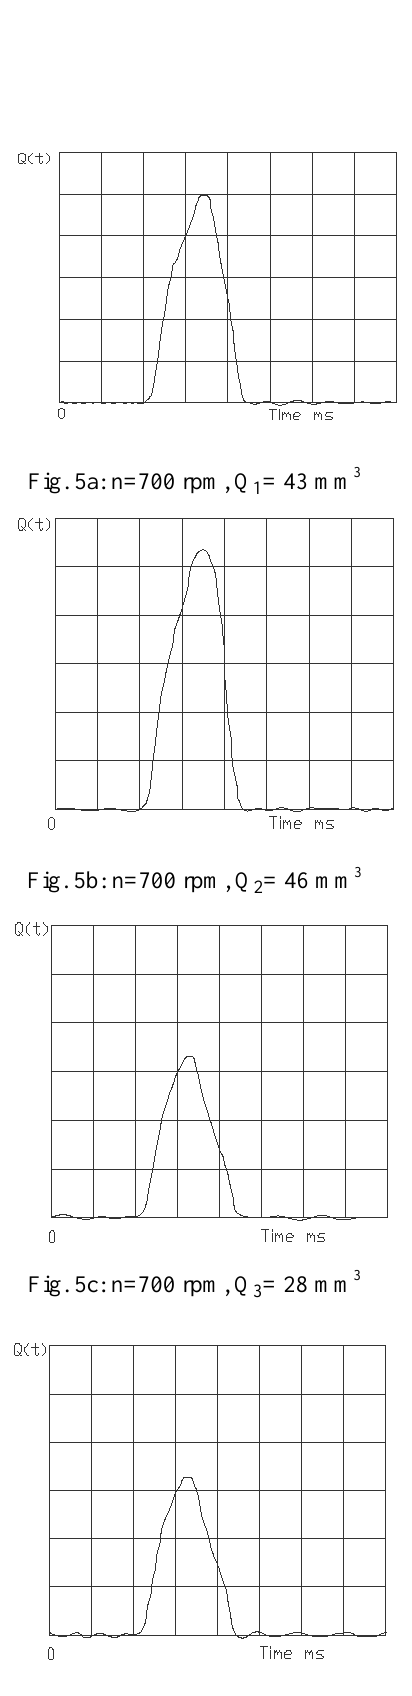
Fig. 5d: n=700 rpm, Q 4 = 28 mm 3